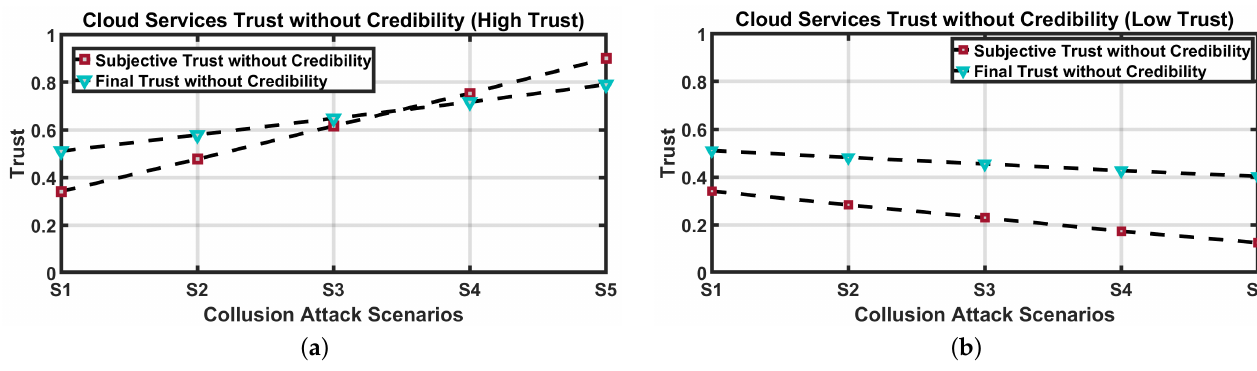
Figure 3. Cloud Services Trust without Credibility: ( a ) High Trust and ( b ) Low